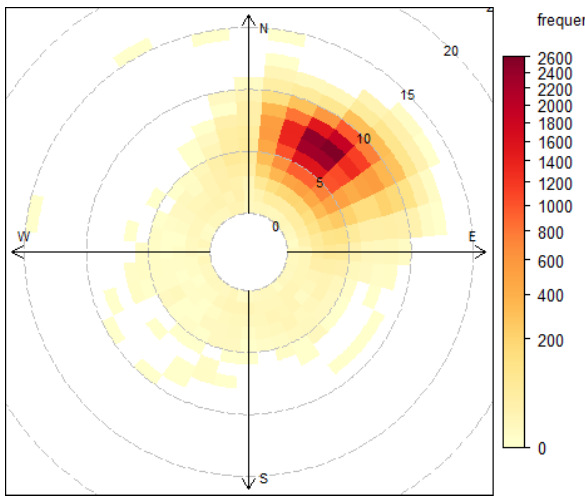
Figure 1. The frequency of hourly averaged wind speed and direc- tion from January 2014 to August 2019. Each square symbolizes 10 ◦ of wind direction and 1ms − 1 wind speed. Each dashed circle shows an increase in wind speed of 5ms − 1